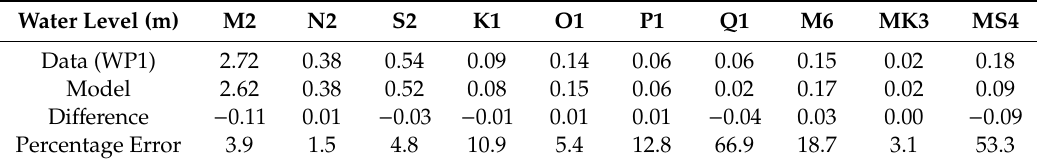
Table 4. Comparison of the observed and modeled water level at WP1 in the Western Passage. Water Level (m) M2